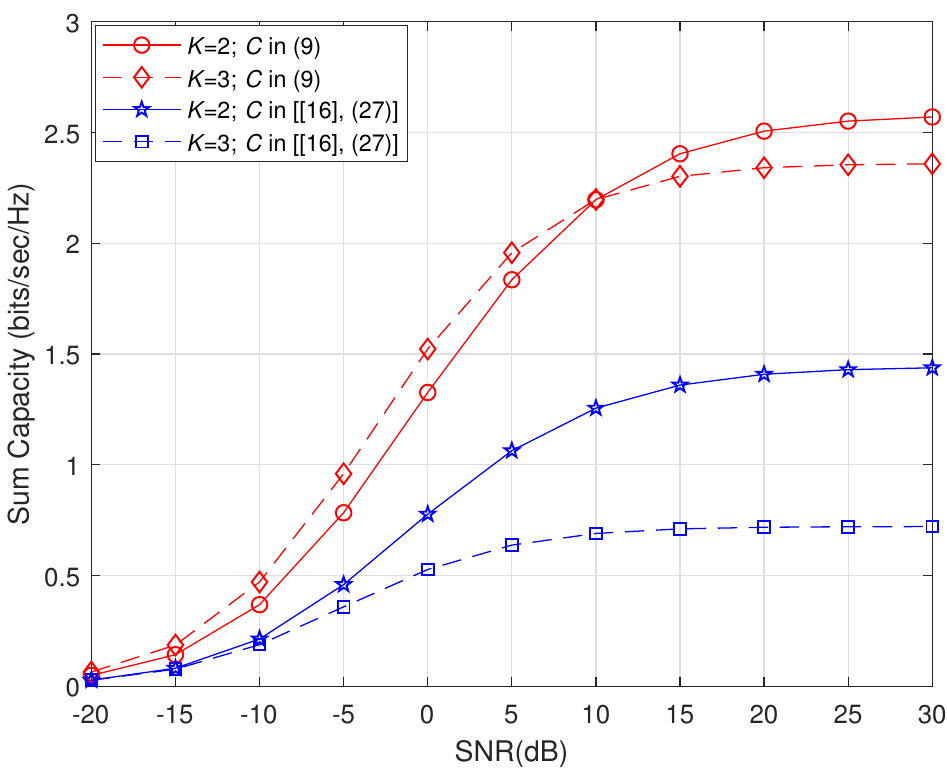
Figure 6. Comparison of the sum capacity versus the transmit SNR in dB. Here, proposed and existing solutions are based on the PEV transmit beamforming